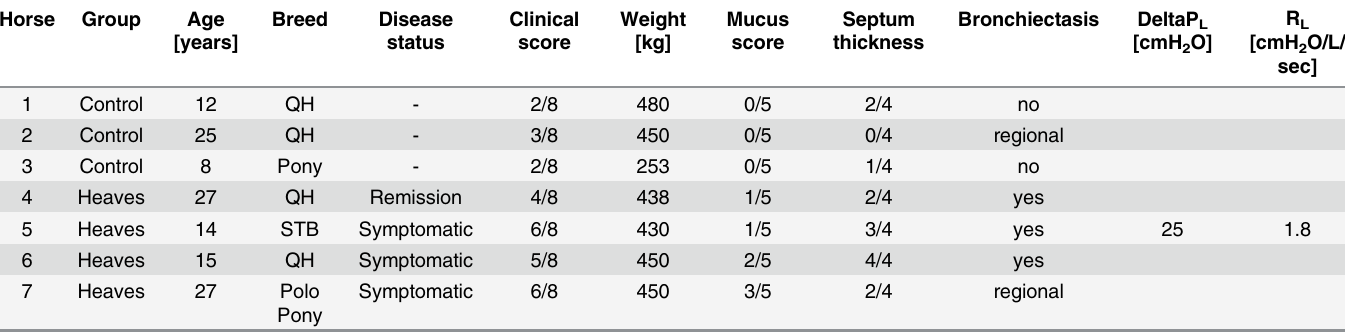
Table 2. Details of the animals studied in in vivo